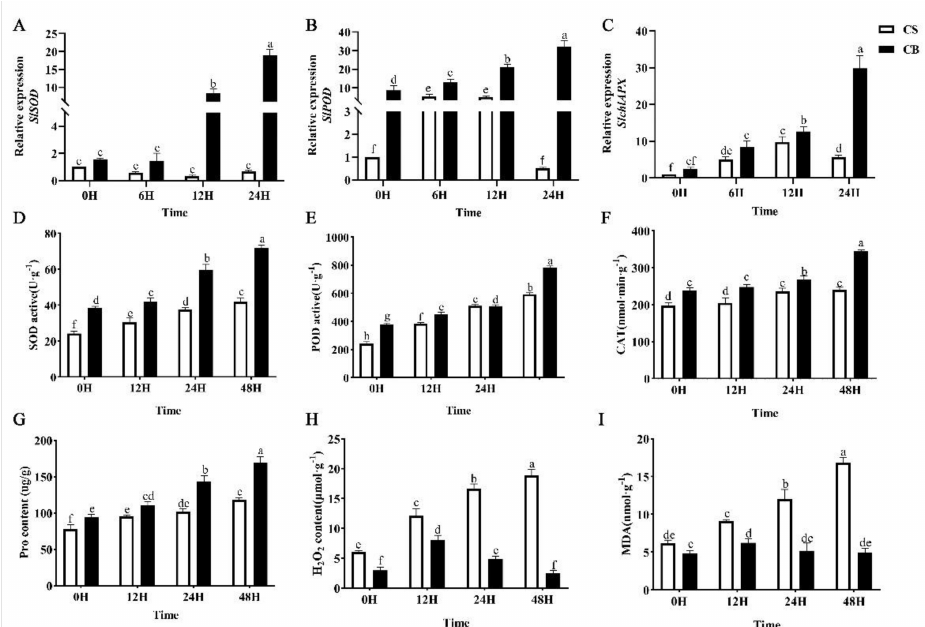
Figure 2. Effects of betaine treatment on the activities of protective enzymes and stress-related growth regulators at 0 h, 12 h, 24 h, and 48 h of tomato seed germination under low-temperature stress. Different lowercase letters indicate significant differences at the 0.05 probability level ( p < 0.05). ( A ) SlSOD , ( B ) SlPOD , ( C ) SlchlAPX , ( D ) SOD activity, ( E ) POD activity, ( F ) CAT activity, ( G ) Pro content, ( H ) H 2 O 2 content, ( I ) MDA content. CS: germination of seeds pretreated with just